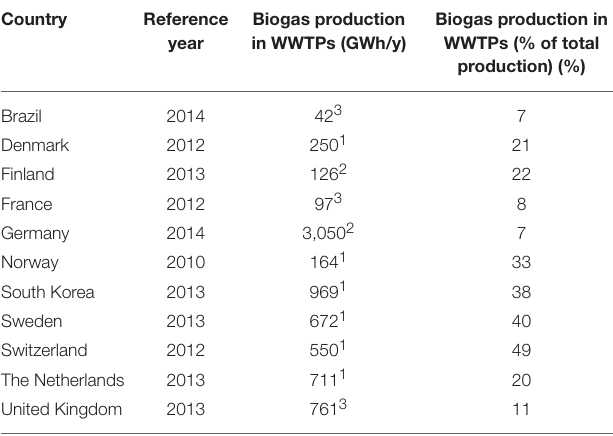
TABLE 3 | Biogas production from WWTP in selected